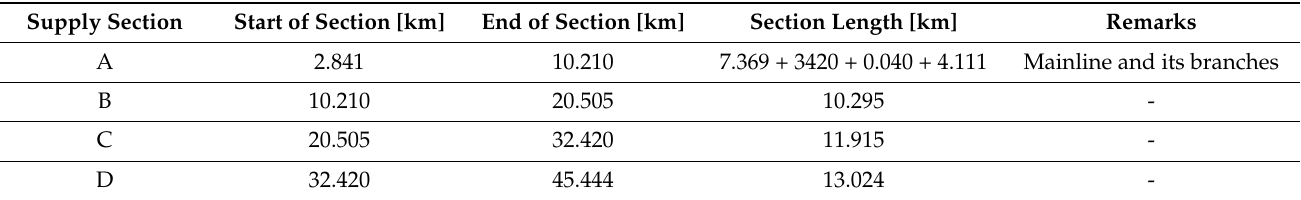
Table 1. Supply sections of the line under